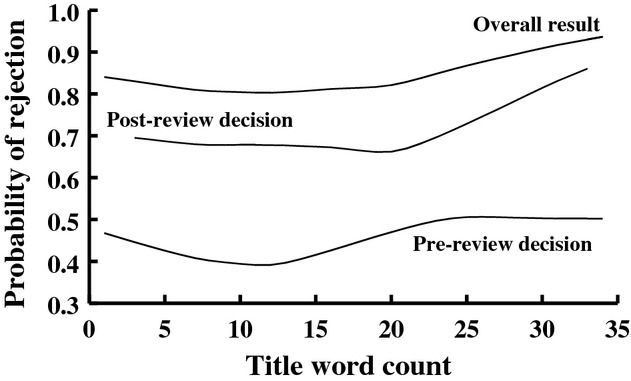
Cubic spline fit (with binomial data) for the probability of rejection versus title word count for papers submitted to Functional Ecology between 2004 and 2013.